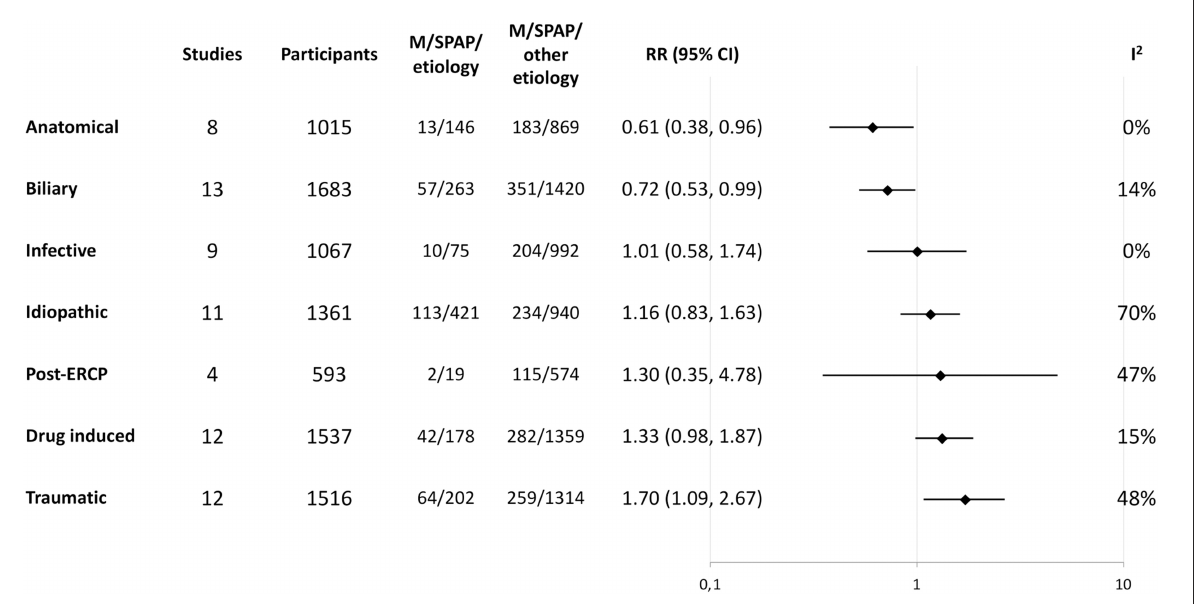
FIGURE3 Summary of moderate or severe disease course risk with different etiologies. Random-effect meta-analysis results are summarized for the etiological factors and ordered according to effect size. The “Studies” and “Participants” columns indicate the total number of studies and participants in the meta-analysis, while the next two columns indicate the number of events (moderate or severe course) in those with the analyzed etiology and those without. CI, confidence interval; M/SPAP, moderate or severe pediatric acute pancreatitis; RR, risk ratio.